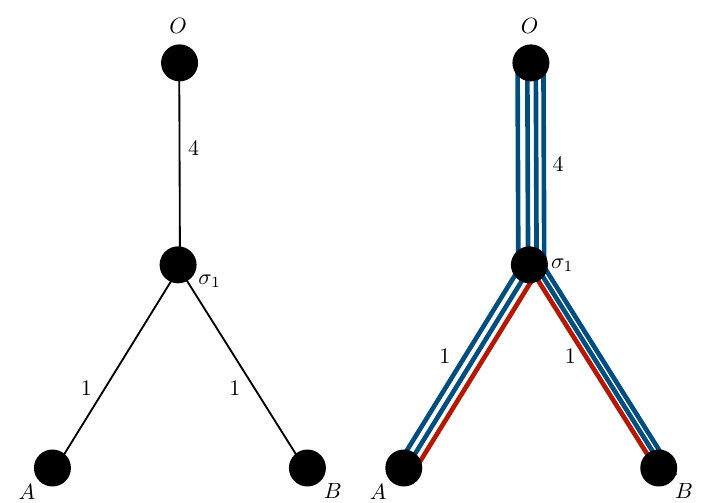
= { 1 , 1; 2 } or K 2 = Figure 18 . L: we consider the following graph which has entropy vector S 2 g g { 0 , 1 , 1 } . R: the optimal thread configuration of (6.23) consists of a single negative 2-thread between A and B as well as four positive 2-threads which obtains an objective value of (4 − 1) ∗ 2 = 6 . The barrier configuration is given by a barrier of one on each edge for a value of 4 ∗ 1 + 1 ∗ 2 = 6 . This is constructed so that every 2-thread crosses a barrier of exactly 2. The entropy vector of the thread configuration is S 2 = { 1 , 1; 4 } or K 2 = {− 1 , 2 , 2 } which is not the same as the graph. In fact, it is µ µ not a valid entropy vector of the holographic entropy cone as it explicitly breaks